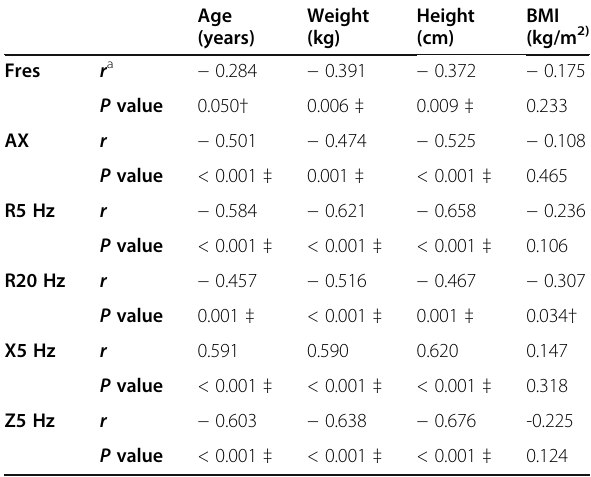
Table 4 Correlation between IOS parameters and both age and anthropometric measures among